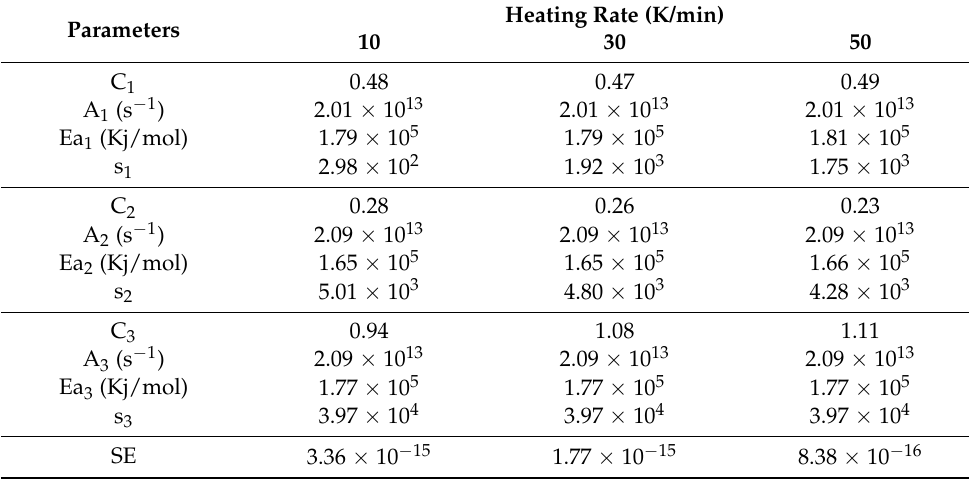
Table 7. Kinetics results DAEM model for the EFB sample.